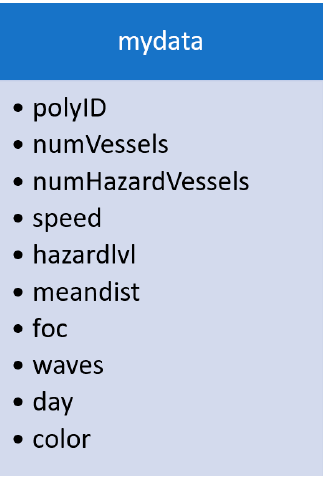
Figure 8. The simulation data are stored in a separate table.